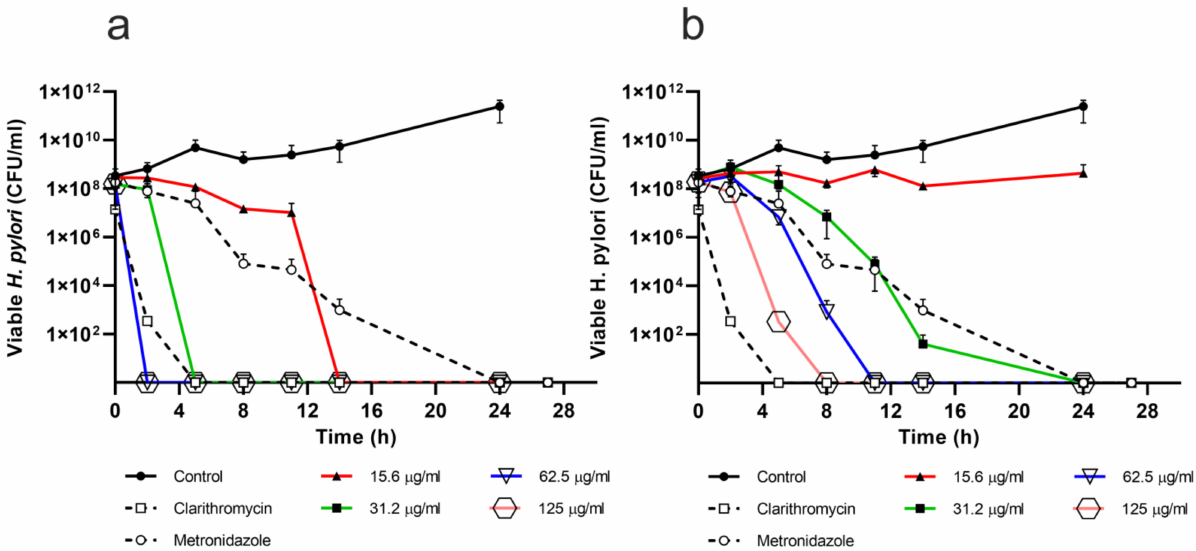
Figure 3. Bactericidal effect of ( a ) estafiatin and ( b ) eupatilin against Helicobacter pylori . Bacterial cultures were exposed to different concentrations (15.6 to 125 µ g/mL) of ( a ) estafiatin or ( b ) eupatilin. Bacterial viability was assessed by the plate colony count technique at different times of incubation. All the experiments were carried out in triplicate and repeated at least three times. Clarithromycin (0.05 µ g/mL) and metronidazole (300 µ g/mL) were used as positive